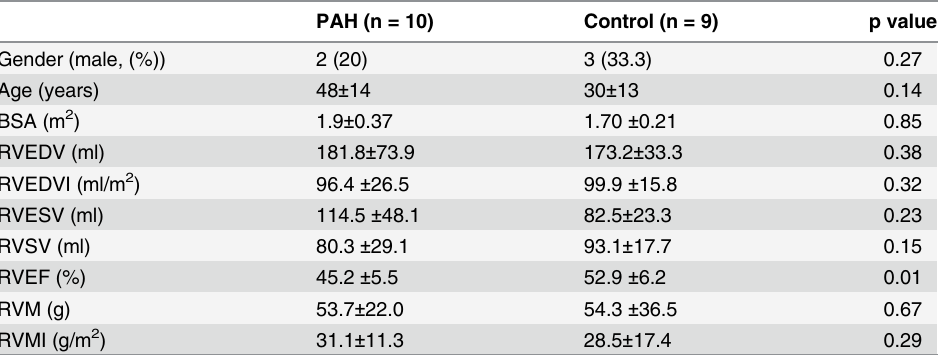
Table 2. Subject RV Functional Characteristics.